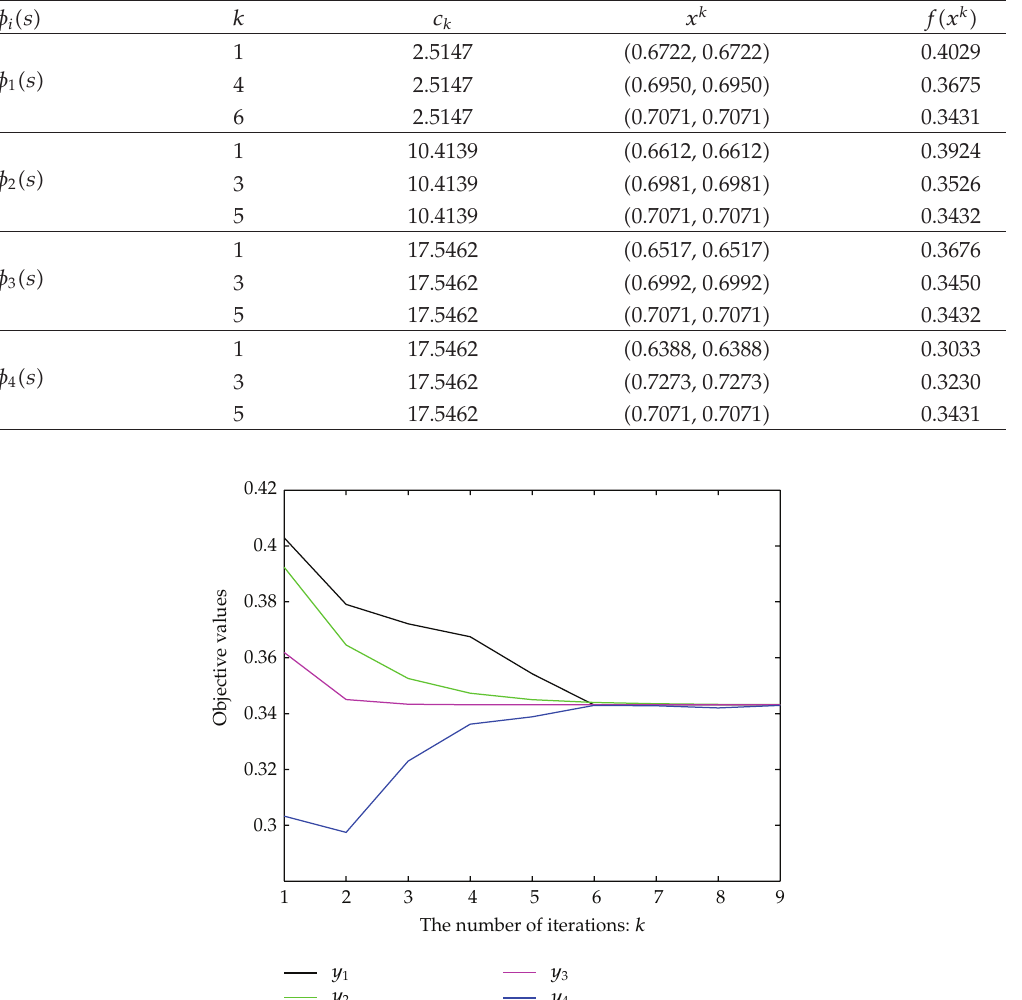
Figure 1: Result of Example